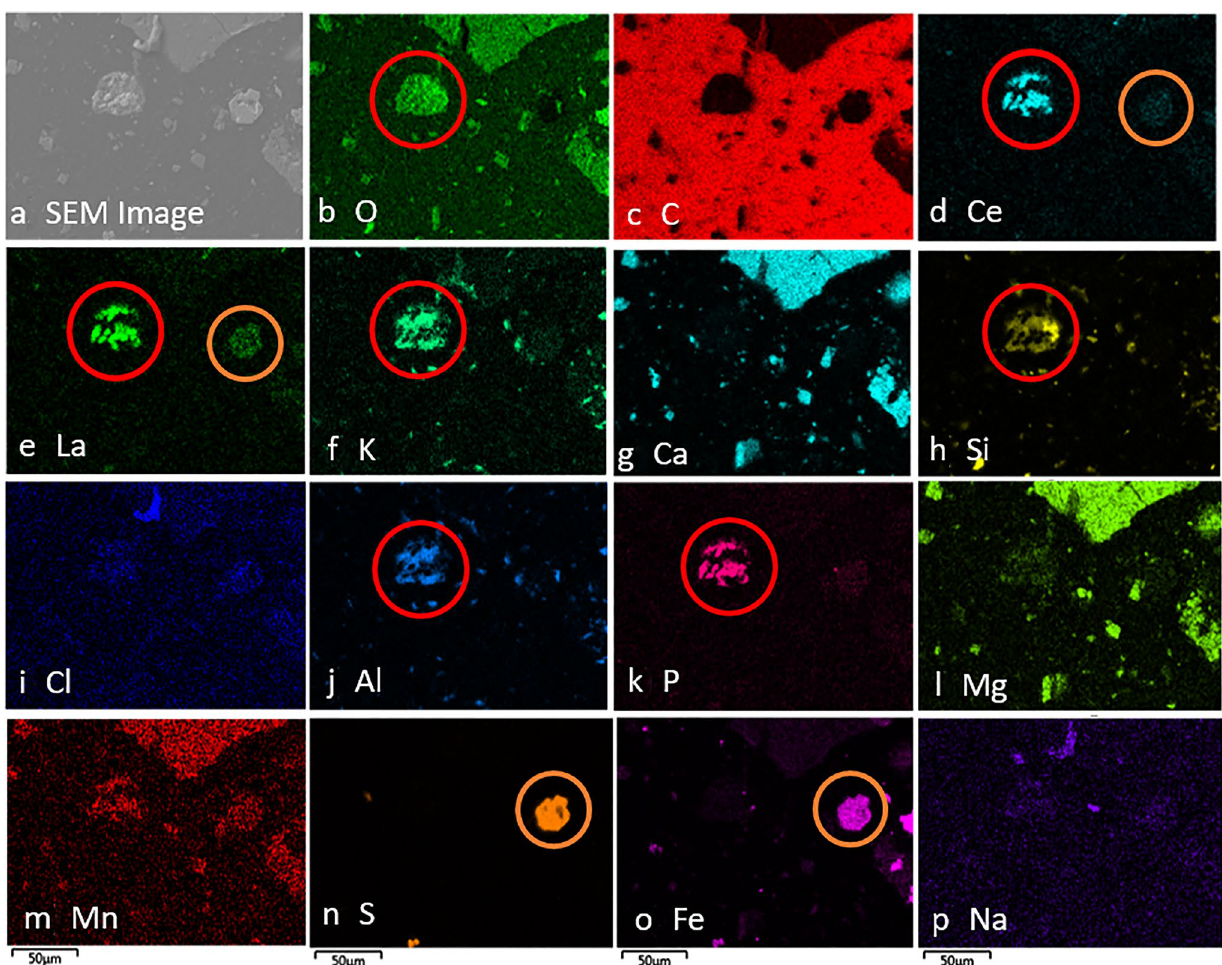
Fig. 2 a SEM image of a region of sample PE-02. b – p Element-specific energy dispersive X-ray spectroscopy images showing the presence of b O, c C, d Ce, e La, f K, g Ca, h Si, i Cl, j Al, k P, l Mg, m Mn, n S, o Fe and p Na in sample